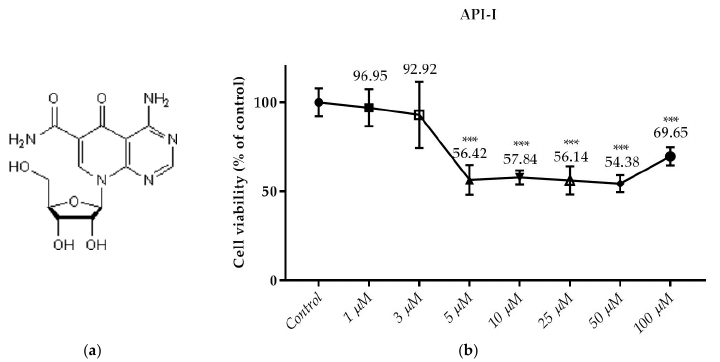
Figure 2. Dynamic monitoring of cell adhesion and proliferation using the xCELLigence system. RL95-2 cell at a density of 40,000; 20,000; 10,000; 5000; 2500; 1250 cells/well in E-Plates 96 were observed during 96 h.